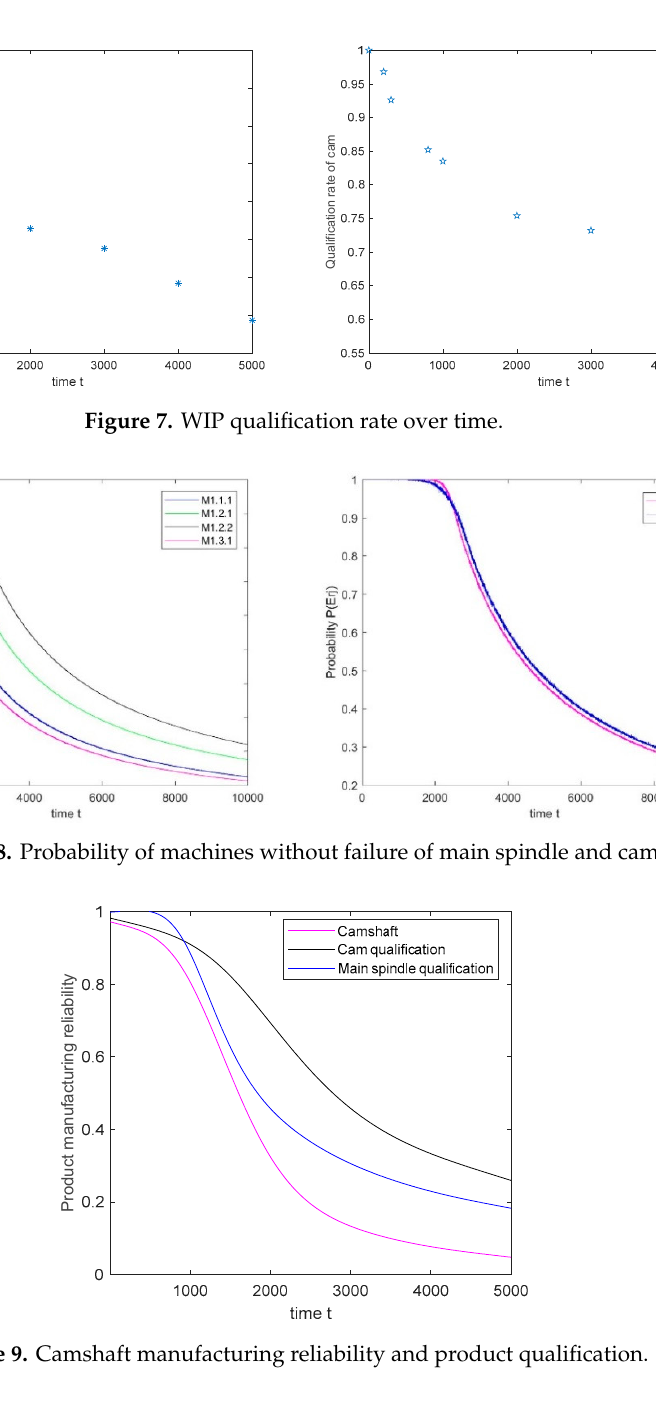
Figure 9. Camshaft manufacturing reliability and product qualification.